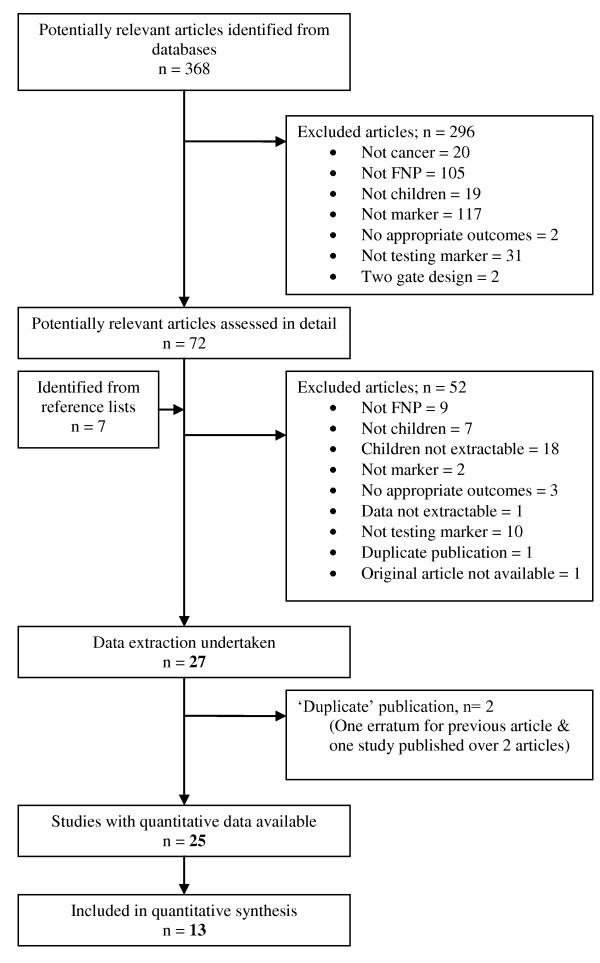
Flow diagram of study selection process.